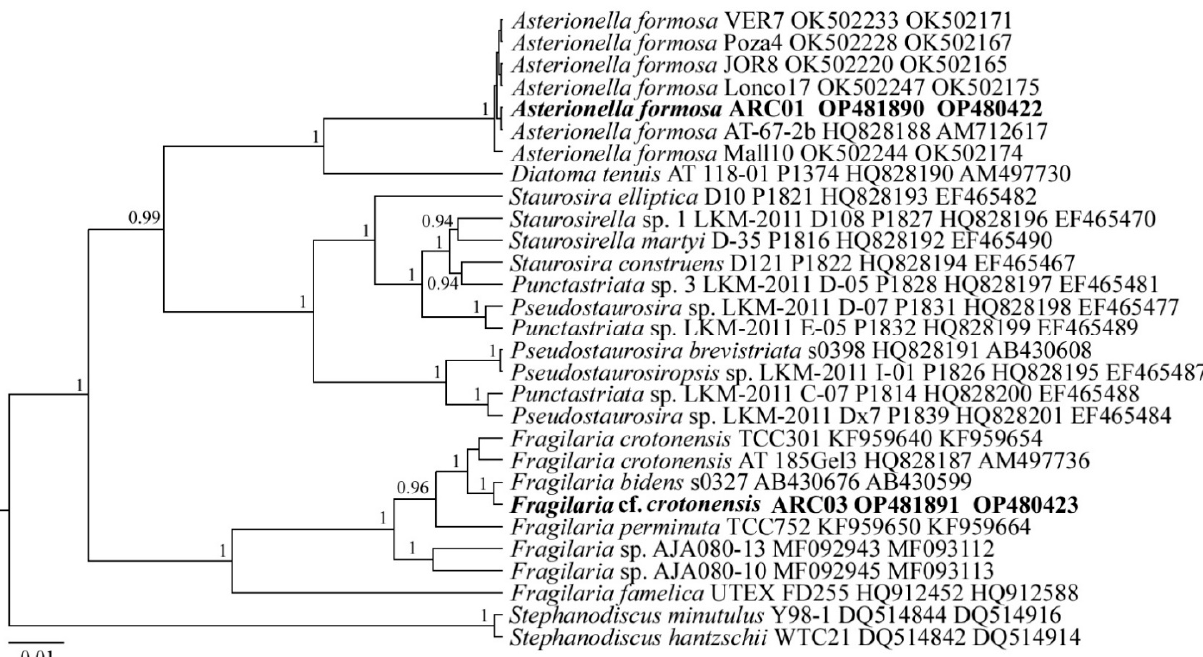
Figure 5. Tribonema. cf. minus (Wille) Hazen. Strain ARC10. Filaments—( a , b ). Scale bars: 10 µ m.